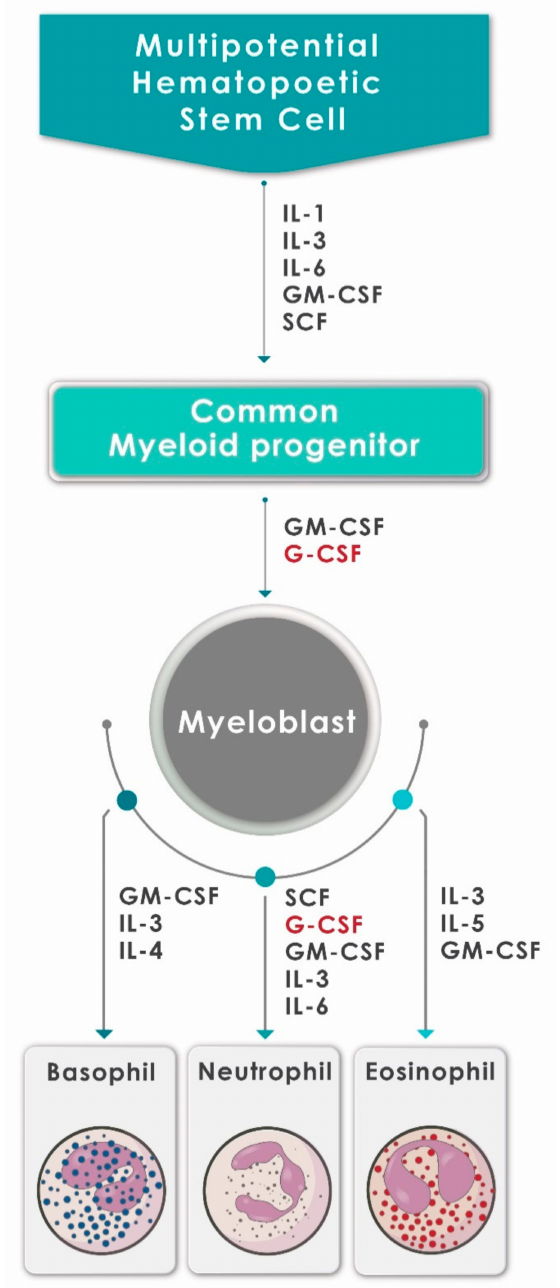
Figure 1. A schematic diagram showing the generation of neutrophils (and other granulocytes) from hematopoietic progenitor cells under the influence of various growth factors and cytokines, including G-CSF (adapted and reproduced from Mehta et al., J Immunol 2015;195:1341–1349; Copyright 2018. The American Association of Immunologists, Inc., Rockville, MD,